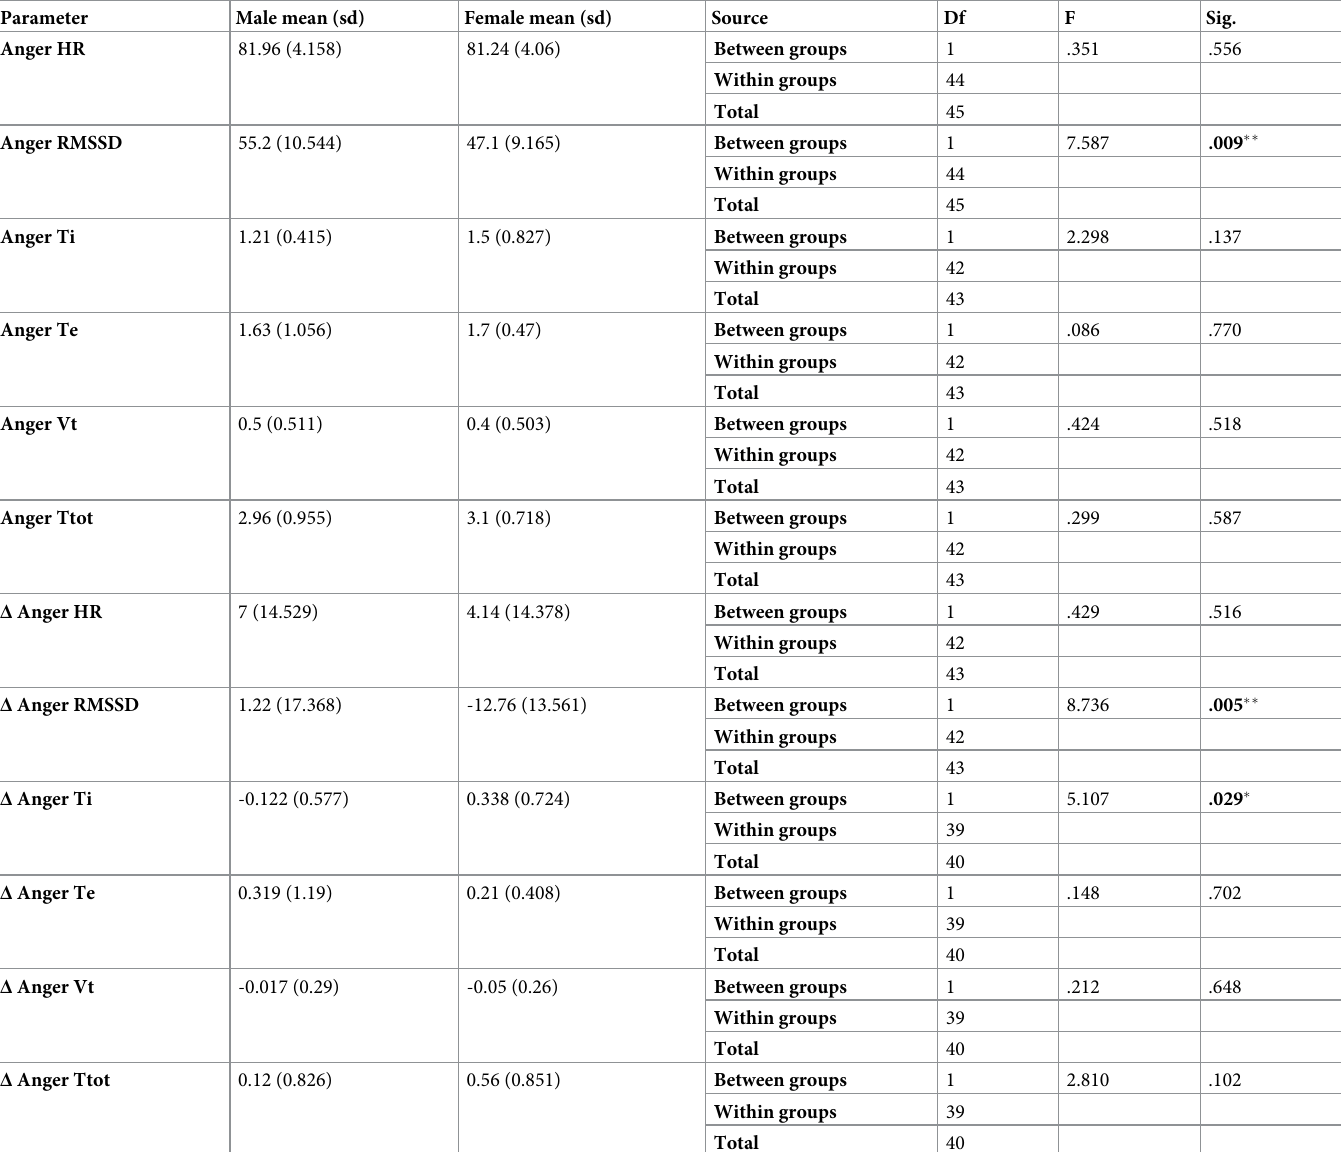
Table 7. ANOVA for autonomic (cardiac and respiratory) response and reactivity during anger of males and females. Parameter Male mean (sd) Female mean (sd)